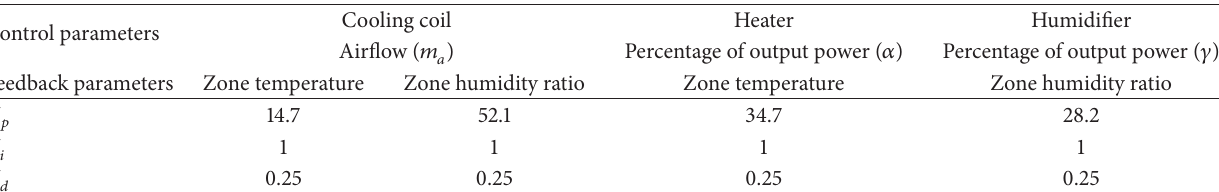
Table 3: Parameters of PID